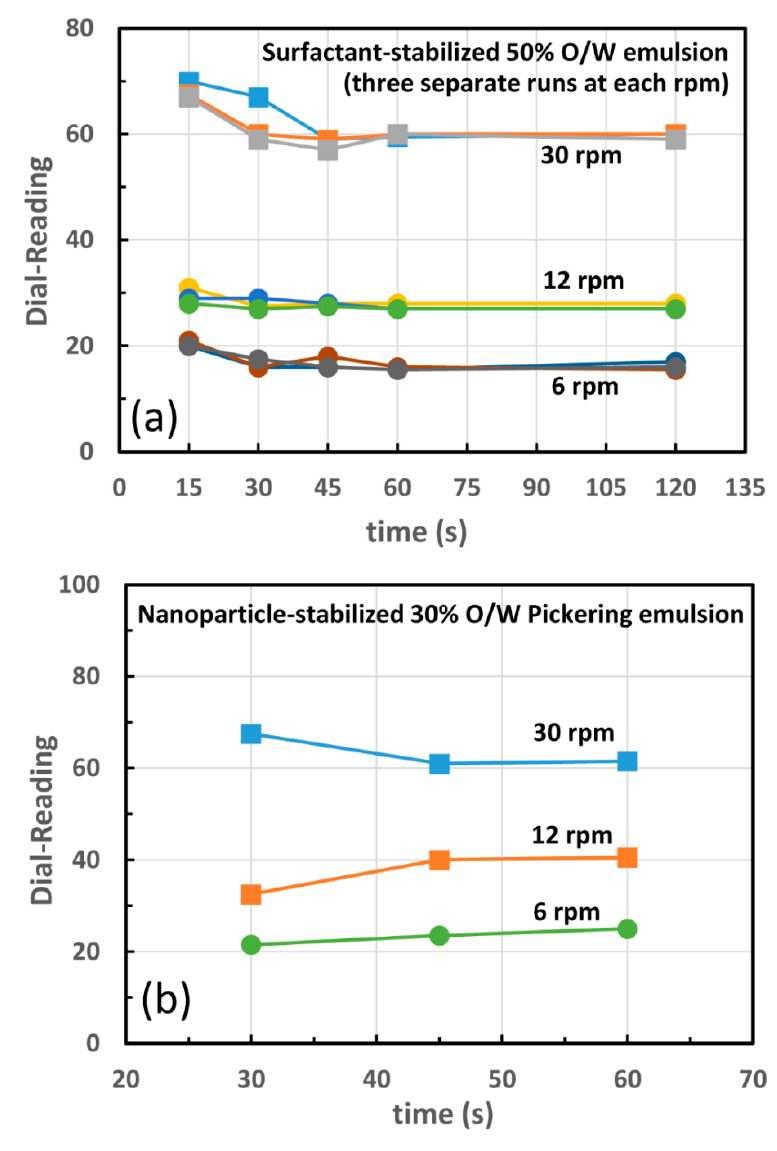
Figure 4. Transient plots of viscometer dial reading for ( a ) surfactant-stabilized and ( b ) nanoparticle-stabilized (Pickering) O/W emulsions at different rpms.